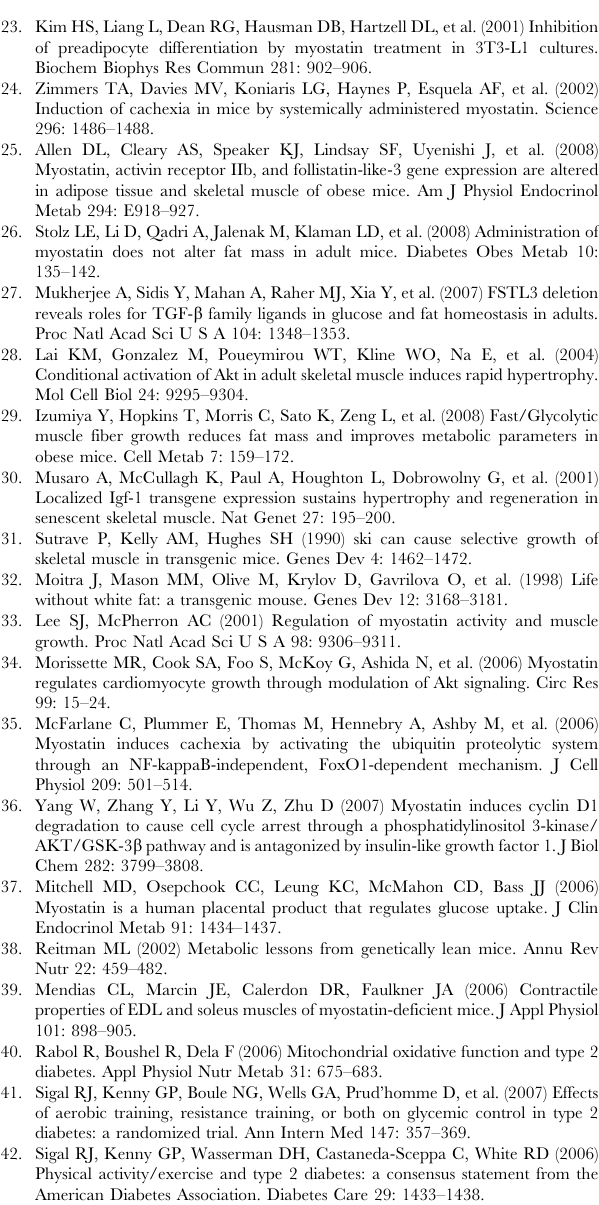
Figure S3 Northern blot analysis of expression of muscle-DN transgene and Gapdh loading control from non-transgenic ( 2 ) and transgenic ( + )